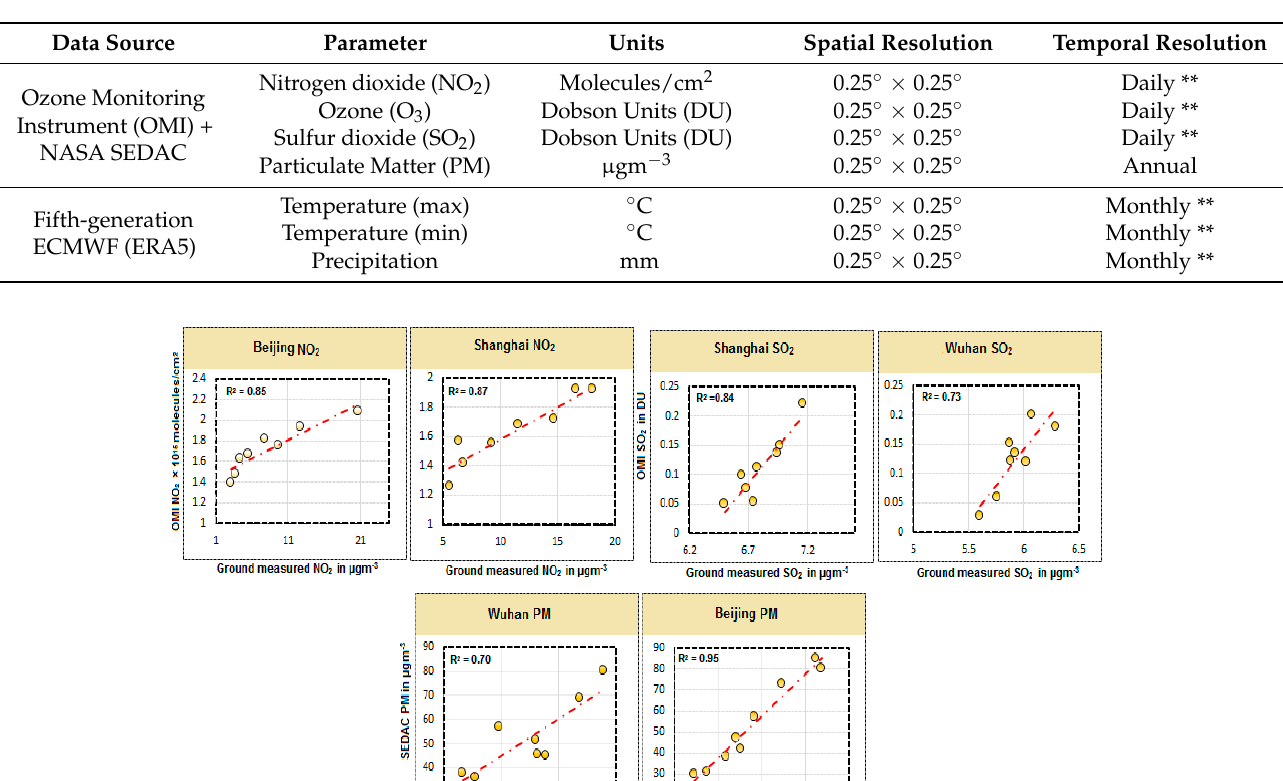
Table 1. Detailed information on data used in the current study. Note: ** Data were averaged into annual values.